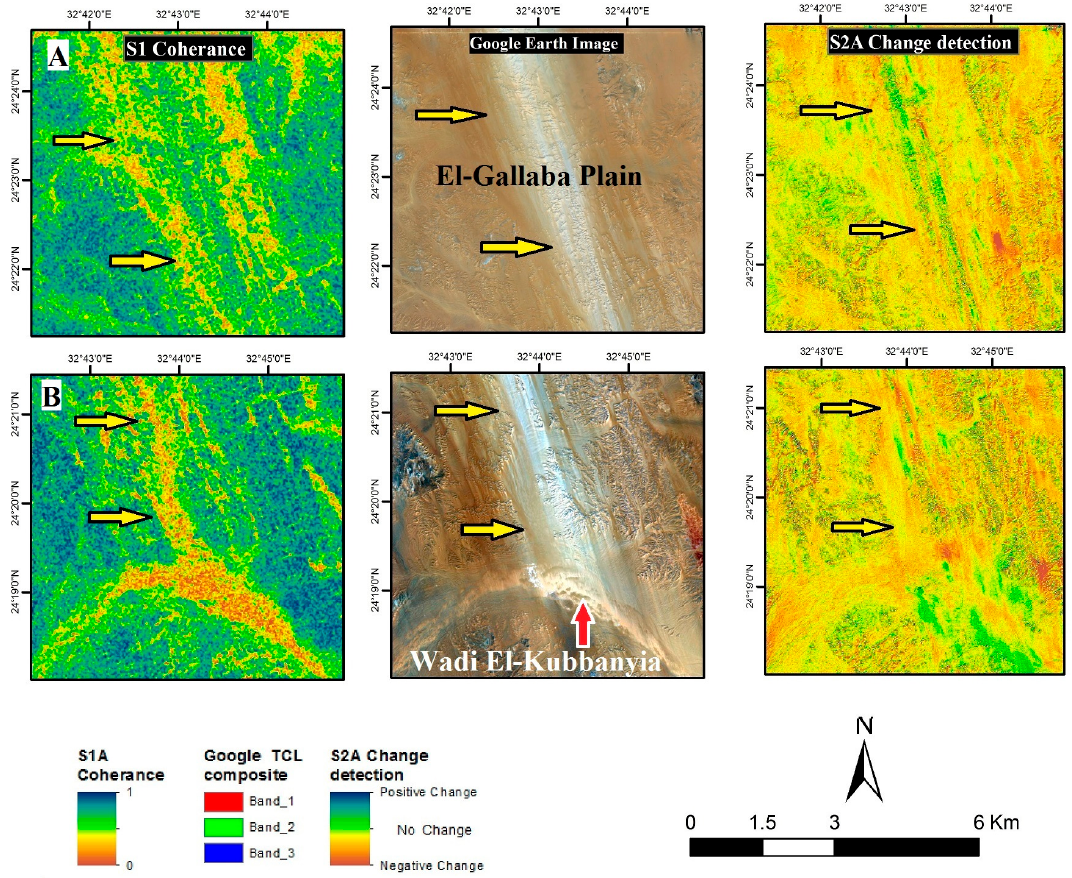
Figure 11. InSAR coherence images (left) of the El-Gallaba Plain show active linear sand dunes (yellow arrows) following the NW–SE direction with low coherence values close to zero (brown color). This linear dune is about to completely trap (dam) its parent’s stream of Wadi Kubbanyia (red arrow), similar to what has already occurred in Wadi El-Matulla. The corresponding optical Google Earth image is shown for comparison (middle). The migrating sand dune is very difficult to recognize on the optical Sentinel-2 change detection data (right).